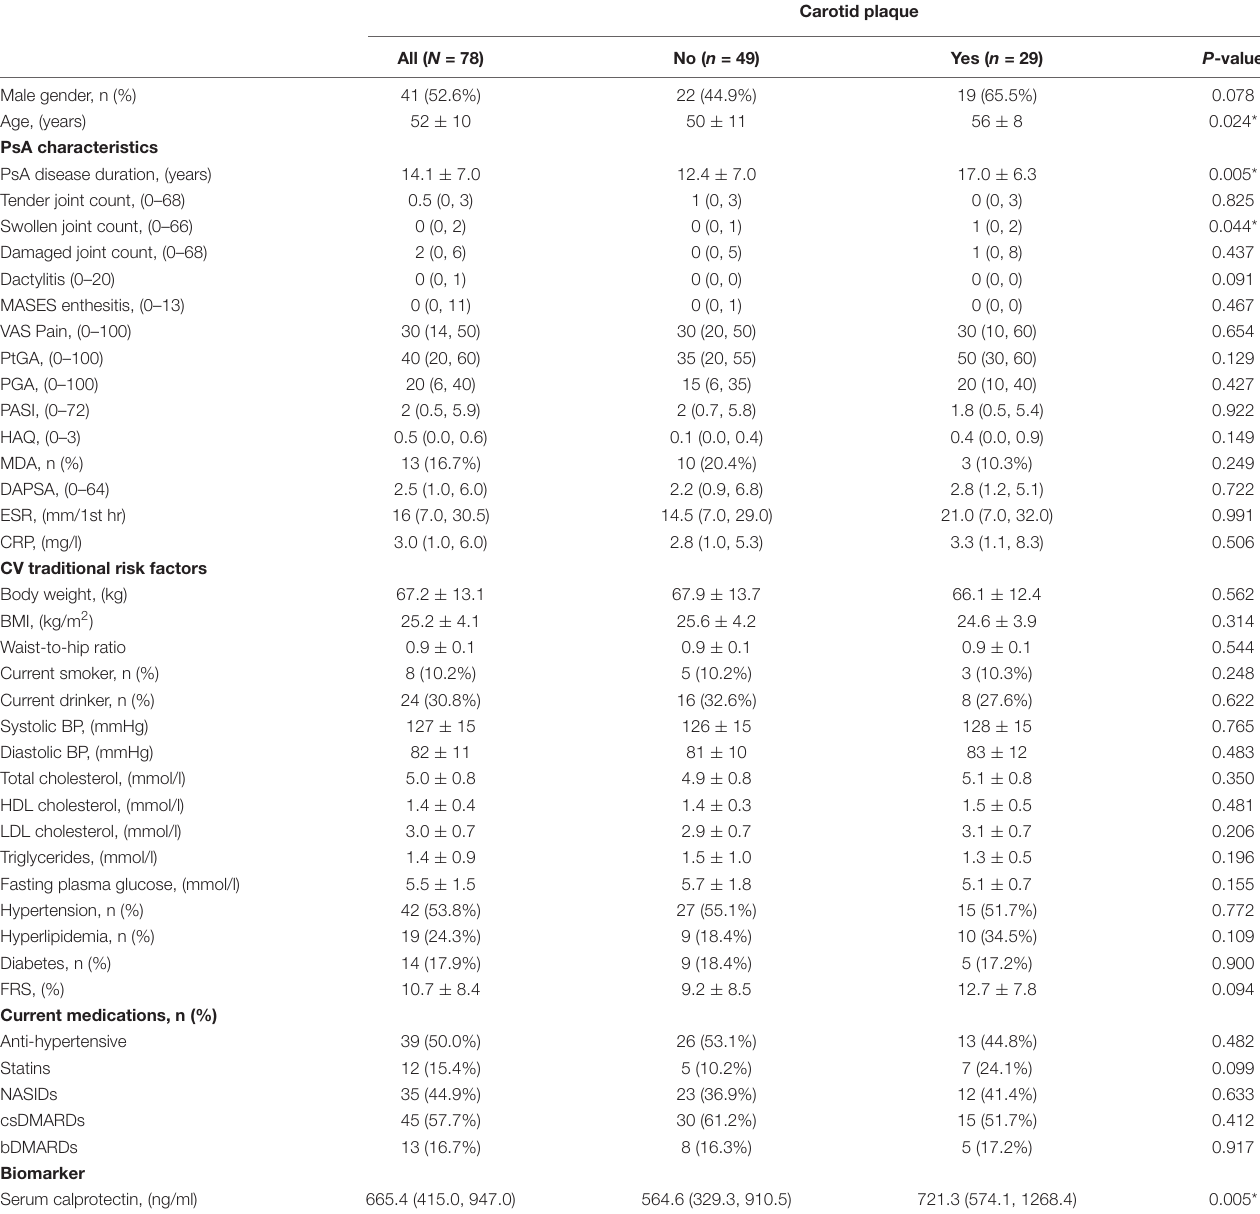
TABLE 1 | Anthropometric and clinical characteristics of PsA patients with or without carotid